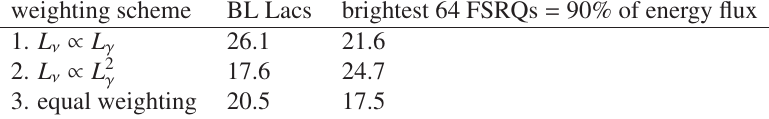
Table 2. Sensitivities for the blazar flare stacking analysis at 90% C.L. in terms of number of signal events from the hypothesis γ = 2, τ = −∞